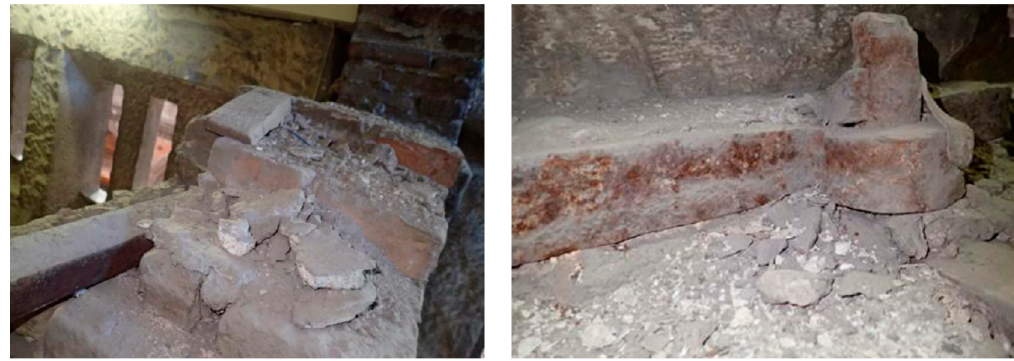
Figure 2. Examples of complex (unclear) boundary conditions.